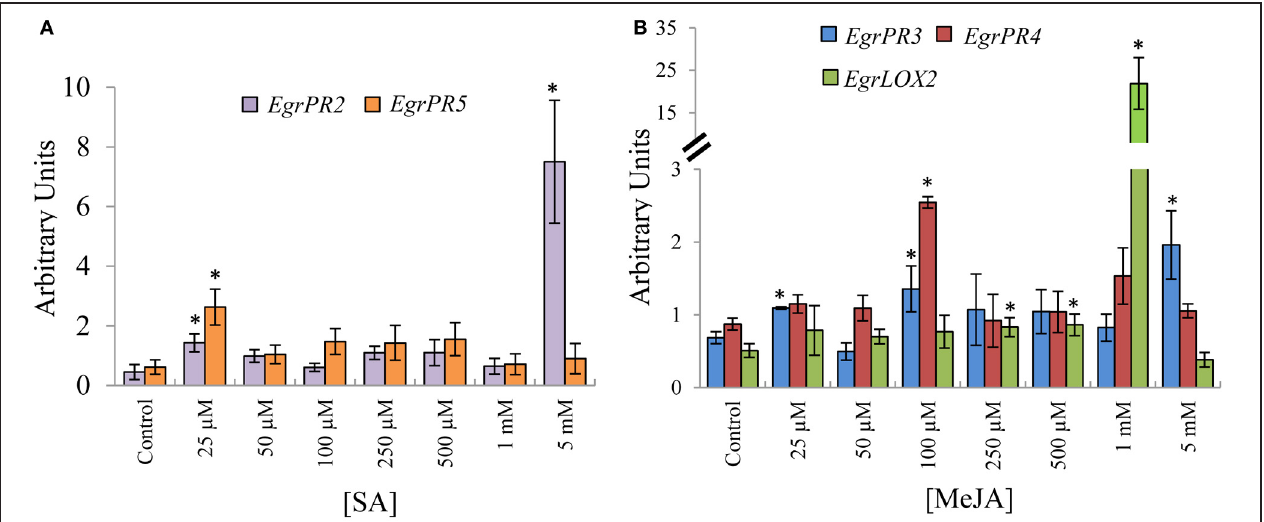
FIGURE 1 | Relative transcript abundance of EgrPR signature defence genes under hormone treatment. (A) Putative SA signature defence genes following normalization with EgrARF and EgrFBA . (B) Putative MeJA signature defence genes following normalization with EgrARF and EgrIDH . The y-axis represents the relative transcript abundance ratios expressed in